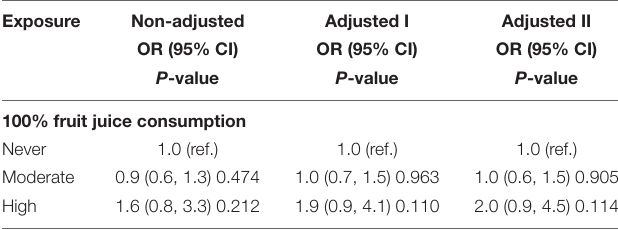
Outcome variate: ARM. Exposure variate: 100% fruit juice consumption. Non-adjusted model adjusts for: none. Adjust I model adjust for: Gender; Age; RACE. Adjust II model adjust for: Gender; Age; RACE; Education Level; PIR; General Health Condition; Body Mass Index (kg/m); Had at least 12 alcoholic drinks per year; Used tobacco/nicotine last 5 days; Diabetes; HBP; High Cholesterol Level; DR; Cataract Operation; Glaucoma. AMD than those without diabetes or diabetic retinopathy